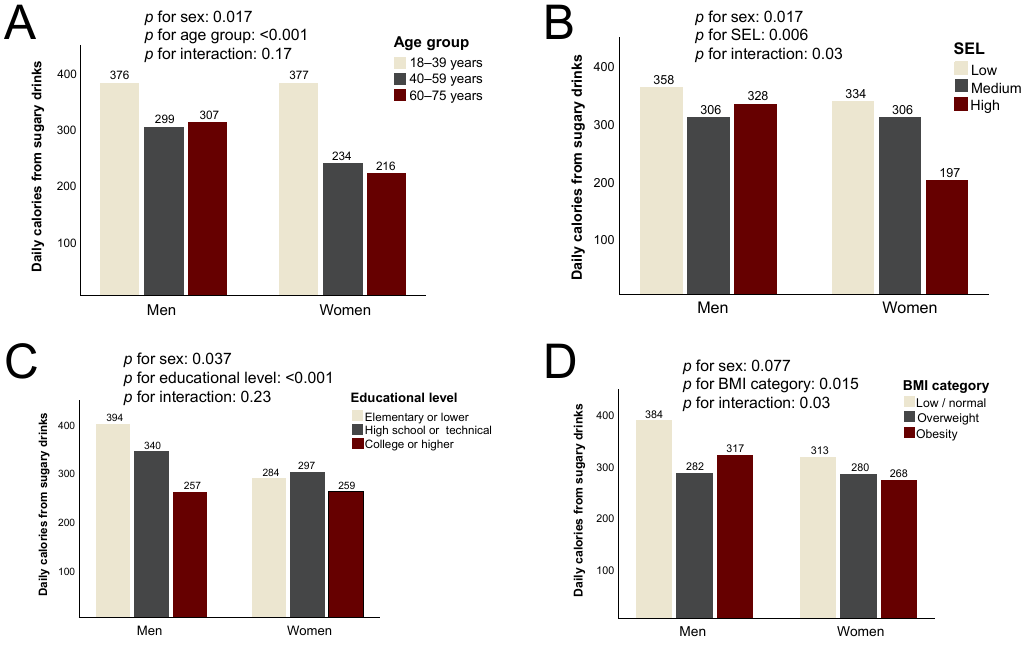
Figure 1. Total daily consumption of calories from sugary drinks among the study partici- pants. Data are mean daily Calories from sugar-sweetened beverages according to ( A ) age group; ( B ) socioeconomic level (SEL); ( C ) educational level; ( D ) body mass index (BMI)